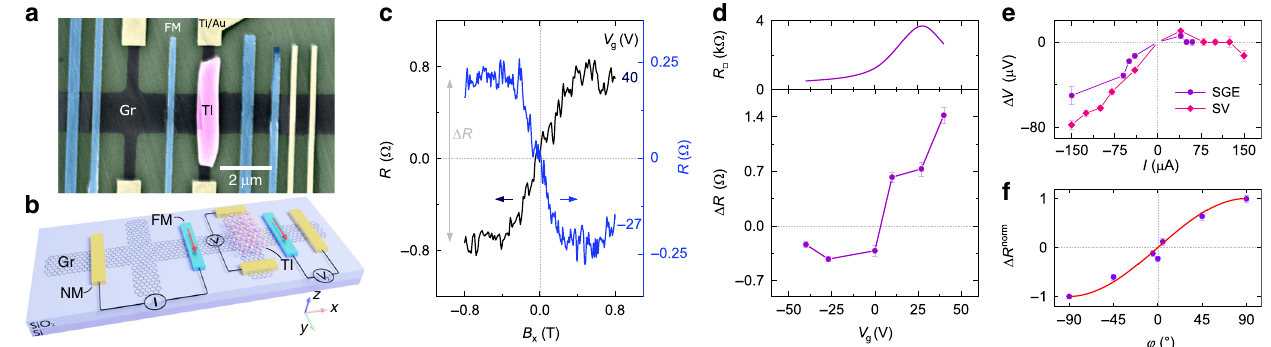
Fig. 4 Spin-galvanic effect in a Gr – TI heterostructure with the FM easy axis along the y-direction. a A colored SEM picture of a representative Gr – TI hybrid device in a Hall bar shape with all ferromagnetic electrodes placed along the y-direction. b A schematic of device 2 and the nonlocal measurement geometry used for probing the SGE ( V ) and reference SV signal ( V 2 ). c SGE signals ( R = V / I ) measured with Fermi level tuned to the conduction ( V g = 40 V) and valence ( V g = − 27 V) bands of proximitized graphene at room temperature. A linear background is subtracted from the data. d Lower panel: The magnitude of SGE signal Δ R as a function of gate voltage. The solid line is a guide to the eye. Upper panel: The gate dependence of graphene channel sheet resistance, showing a CNP at V g = 27 V. e The nonlocal voltage amplitude for the SGE and reference SV signals versus the bias current. Both signals are obtained with the same injector FM contact at T = 300 K and V g = 0 V. Solid lines are guides to the eye. f Normalized amplitude of the SGE signal Δ R as a function of the angle φ between the magnetic fi eld B and the y -axis in the graphene plane. The red line shows the expected trend ~sin( φ ). The measurements were performed with T = 300 K, I = − 150 µ A, and V g = 40